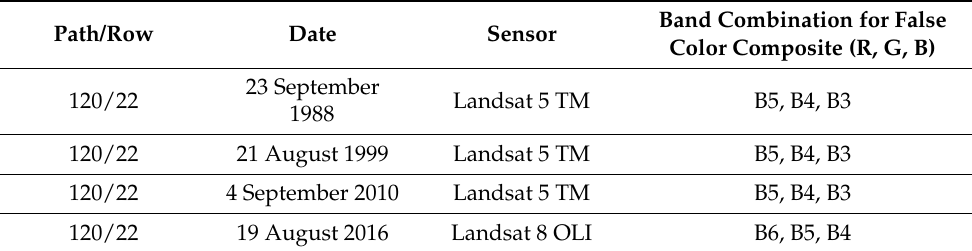
Table 1. List of processed Landsat images.